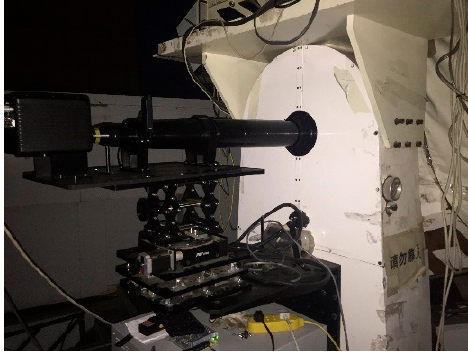
Figure 6. Infrared-K band photoelectric system practicality picture.